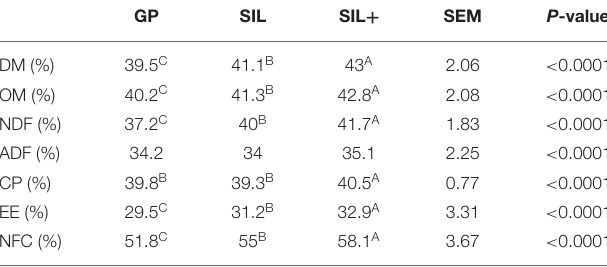
TABLE 5 | Percentage of disappearance after in vitro digestion in grape pomace (GP), after silage with (SIL + ) or without (SIL) L. plantarum 5BG. GP